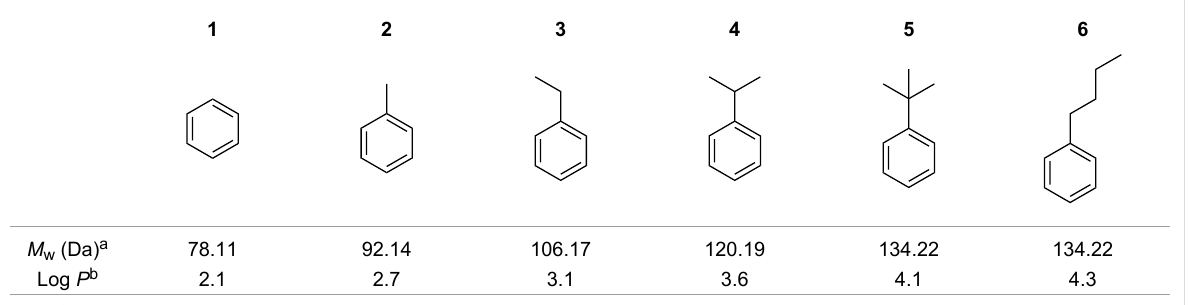
Table 2: Overview of the volatile organic compounds studied including some physical characteristics. 1